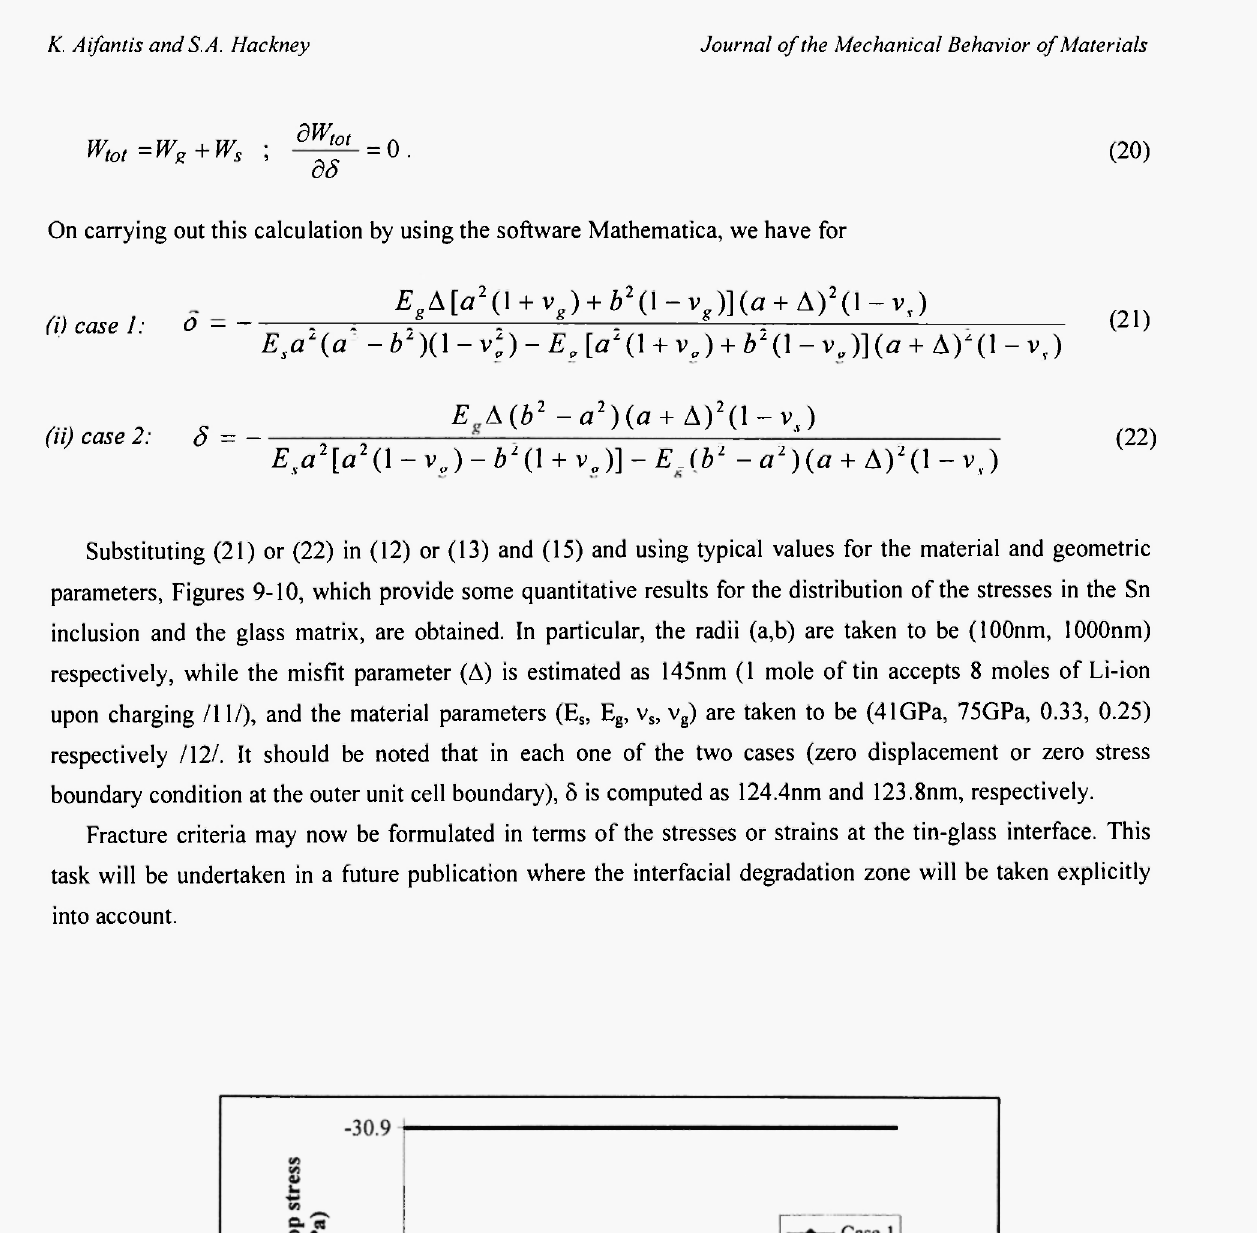
Fig. 9: Radial stress distribution in Sn